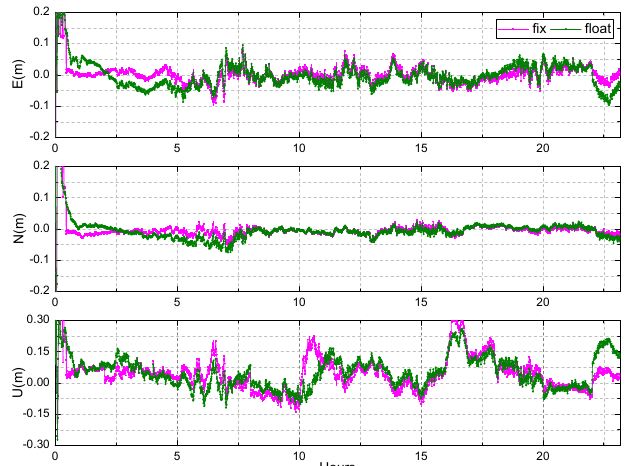
Figure 21. The results of BDS kinematic PPP AR at KAT1, on DOY 083 of 2018.